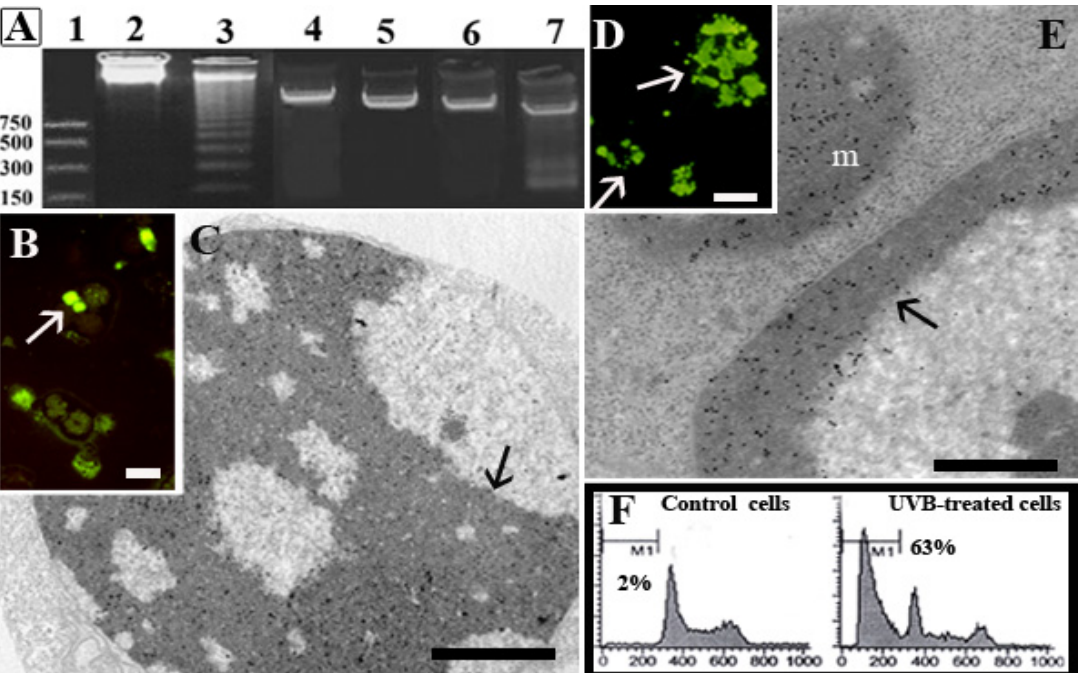
Figure 2. In HL-60 (lane 2), Molt-4 (lane 4) and U937 (lane 6) control cells, as well as in UVB-treated Molt-4 (lane 5), DNA cleavage is absent ( A ). In treated HL-60 (lane 3) and U937 (lane 7) cells, the ladder, due to oligonucleosomic fragmentation, appeared. Terminal deoxynucleotidyl transferase-mediated dUTP nick-end labeling reaction at fluorescence microscope (TUNEL/FM) ( B , D ) and TUNEL/TEM ( C , E ) of Molt-4 ( B , C ) and U937 ( D , E ) cells. Fluorescent micronuclei (arrows) are evident in both cases ( B , D ). Colloidal gold particles can be detected in dense chromatin ( C , E , arrows) and micronuclei (m) appear labeled ( E ). U937 cell DNA content, evaluated by flow cytometry is shown in ( F ). A sub-G1 peak (63%) is revealed in treated cells, whereas it is absent in the control ones. Scale bars: ( B , D ) 20 µm; ( C ) 0.5 µm; ( E ) 0.1